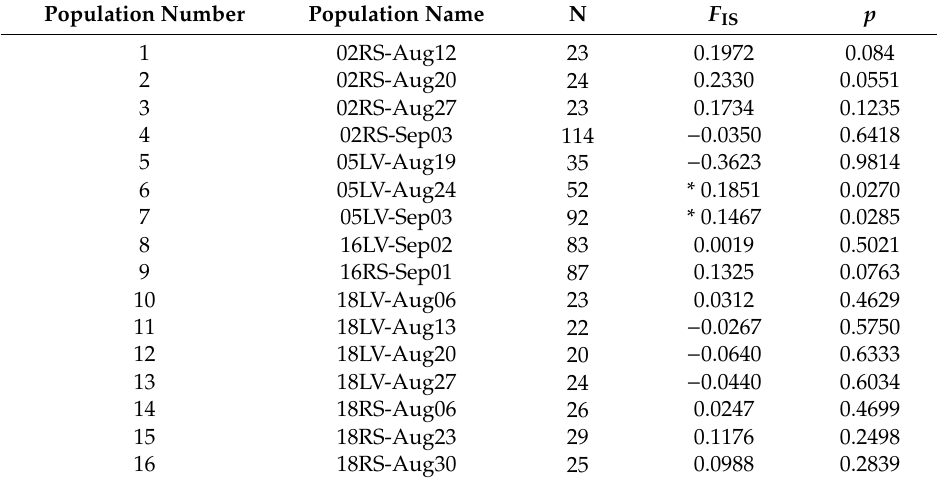
Table 2. Population specific inbreeding coe ffi cient ( F IS ) indices (10,100 permutations) estimated for 16 putative populations of Helicoverpa zea . A negative value represents an essentially zero F IS index. The first two digits of the population name represents the collection year and the next two letters represent the collection site followed by the collection date; Rock Springs (RS), Landisville